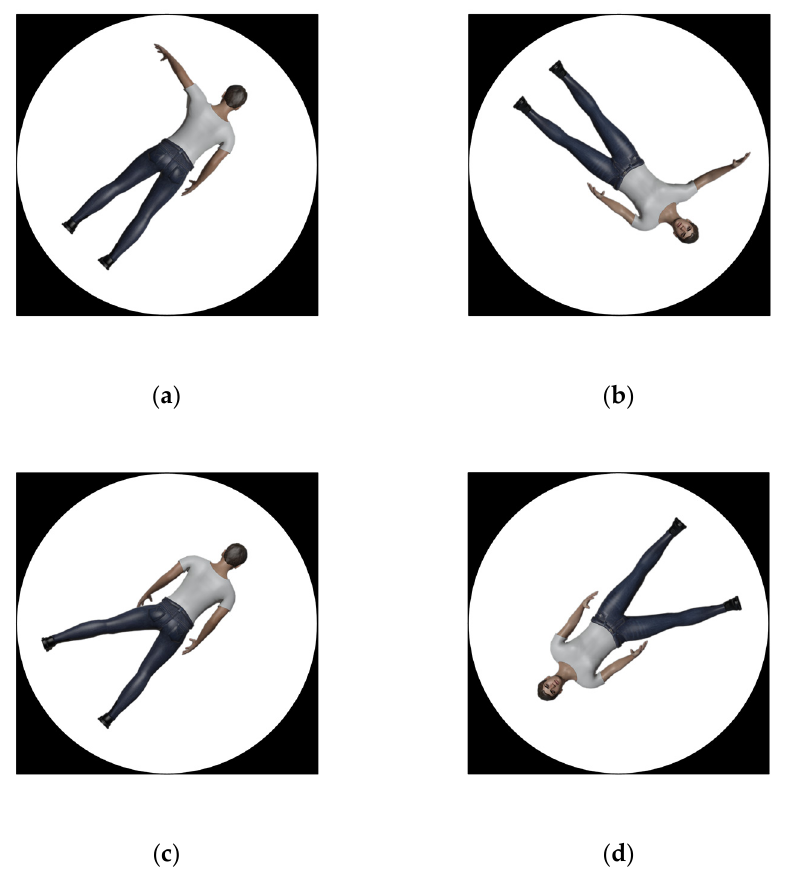
Figure 3. Depiction of the realistic stimuli in Study 2. ( a ) Back view of the left arm raised. ( b ) Front view of the right arm raised. ( c ) Back view of the left leg raised. ( d ) Front view of the right foot raised.